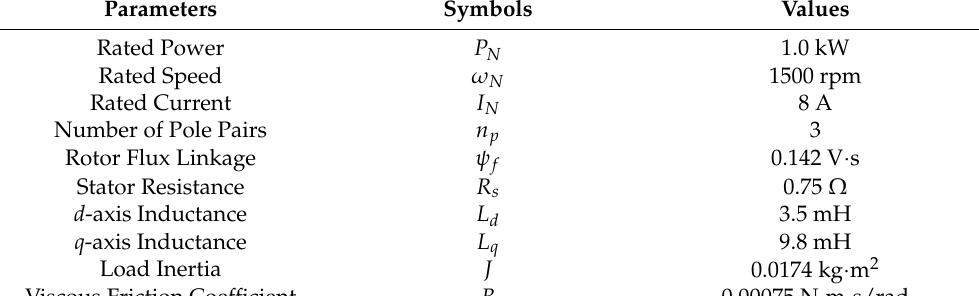
Table 1. IPMSM Parameters.